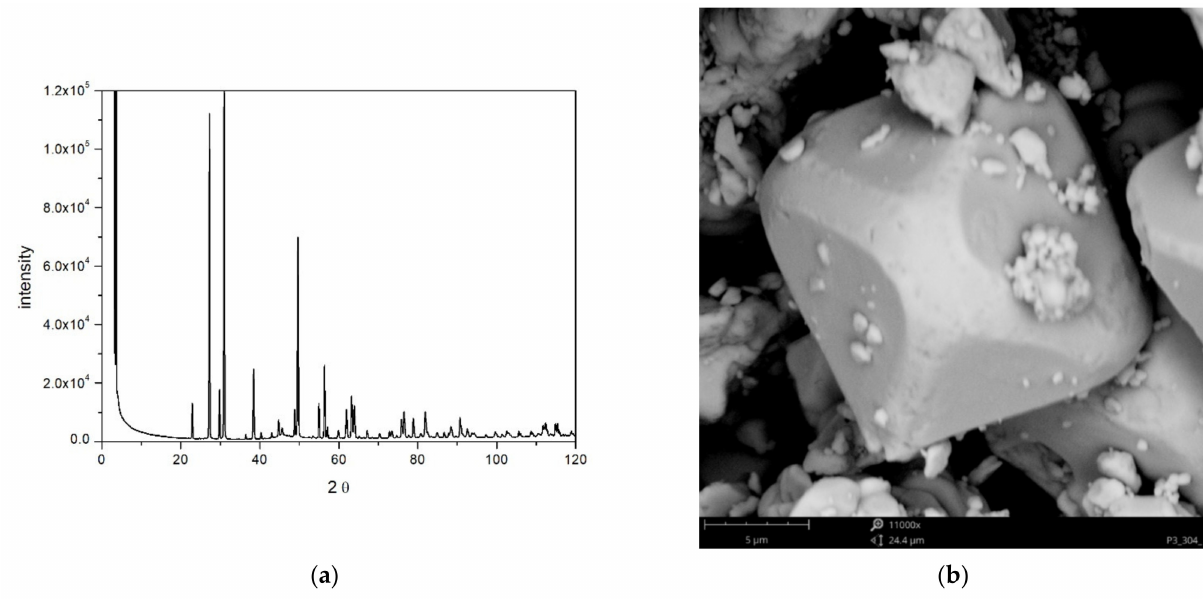
Figure 1. ( a ) The XRD pattern. ( b ) Photograph of TeO 2